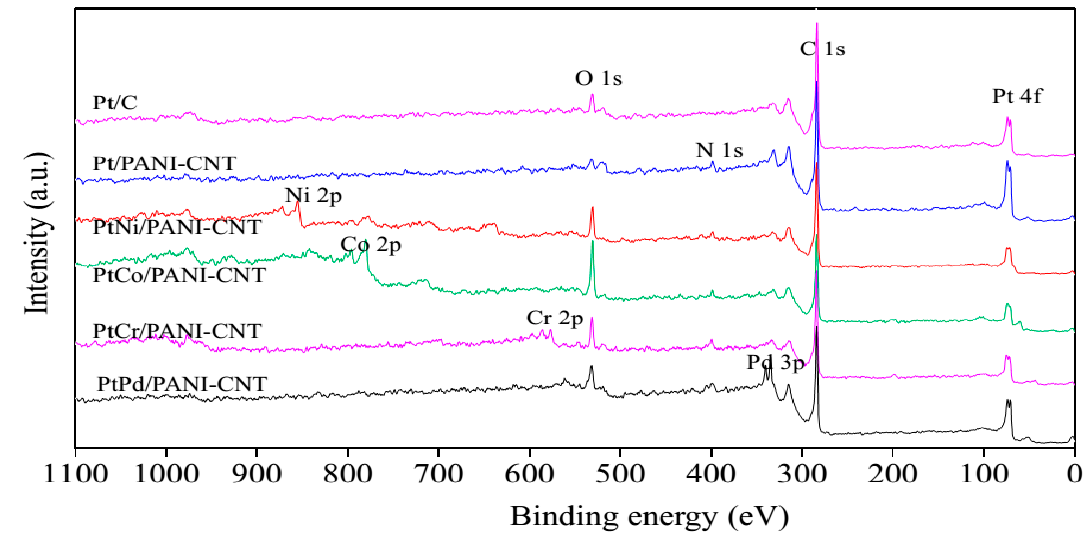
Figure 4. Representative of XPS spectra of the different catalysts.